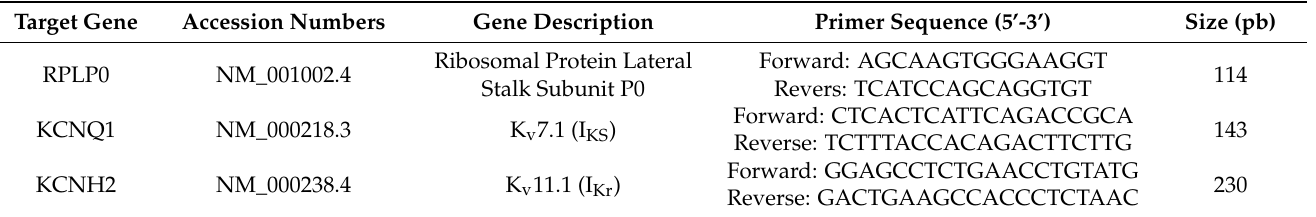
Table 1. Summary of genes evaluated in this study. Target gene, accession numbers, gene description, primer, and product